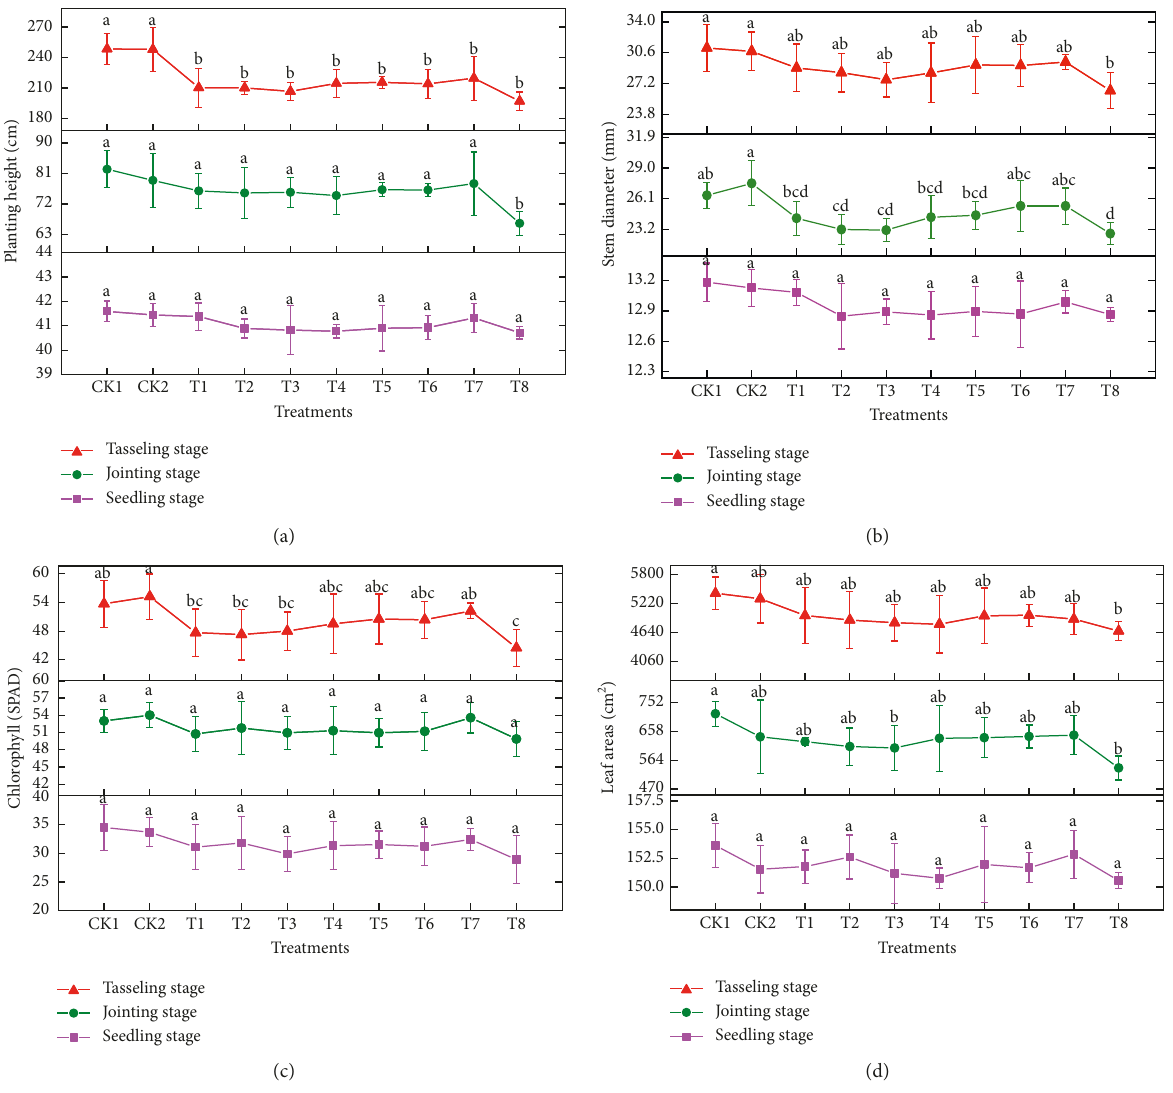
Figure 5: Planting height, stem diameter, chlorophyll, and leaf areas of different treatments at seedling, jointing, tasseling, and mature stages.